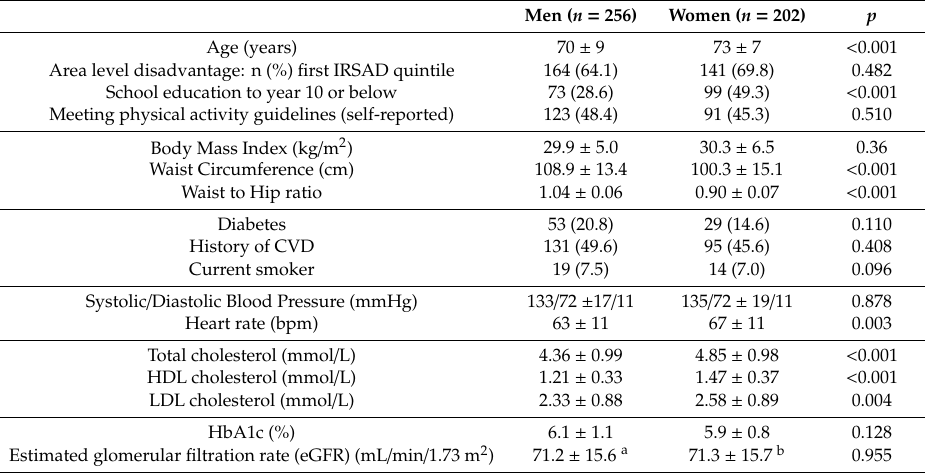
Table 1. Demographic and cardiometabolic risk factor